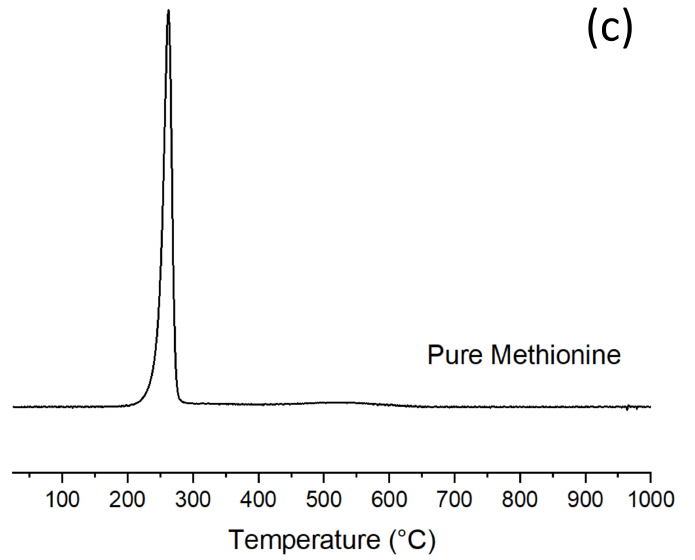
Figure 7. Thermogravimetric analysis in air of MET–ADS samples at three and six contacting